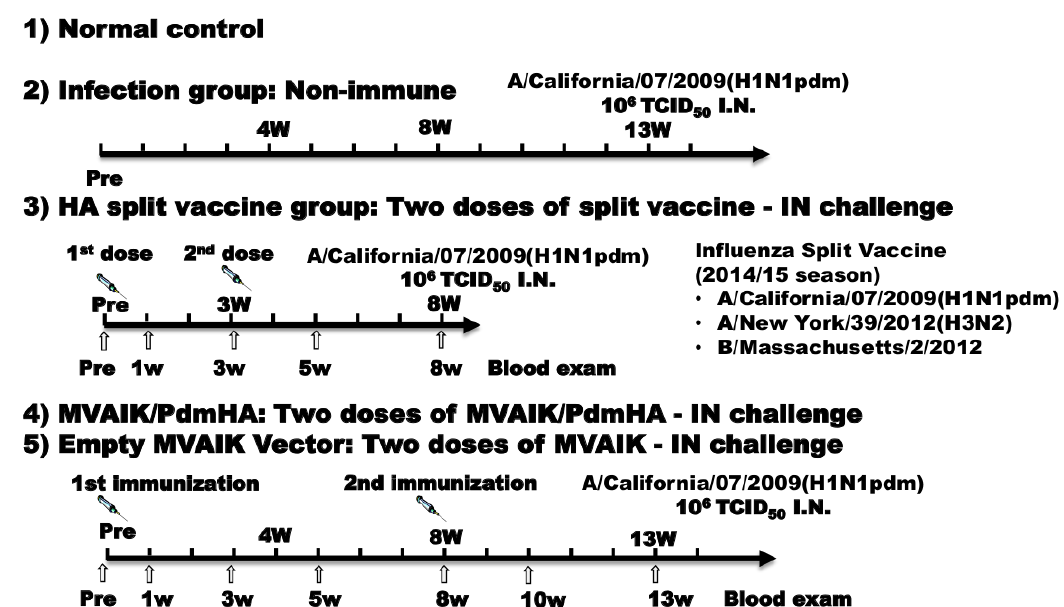
Figure 1. Experimental schedule. (1) Normal control group: non-immunized true control. (2) Infection group: non-immunized group was challenged with A/California/07/2009(H1N1pdm) following the same schedule as the following groups. (3) The HA split vaccine group was immunized with two doses of 0.1 mL of the seasonal HA split vaccine with a three week-interval. (4) The MVAIK/PdmHA group was immunized with two-dose recombinant virus before and 8 weeks after the first dose and challenged at 13 weeks. (5) The empty MVAIK vector group was immunized with the empty MVAIK vector. Blood was sampled prior to dosing and at 1, 3, 5, 8, 10, and 13 weeks after the first dose. Three cotton rats aged 6–8 weeks were used in each